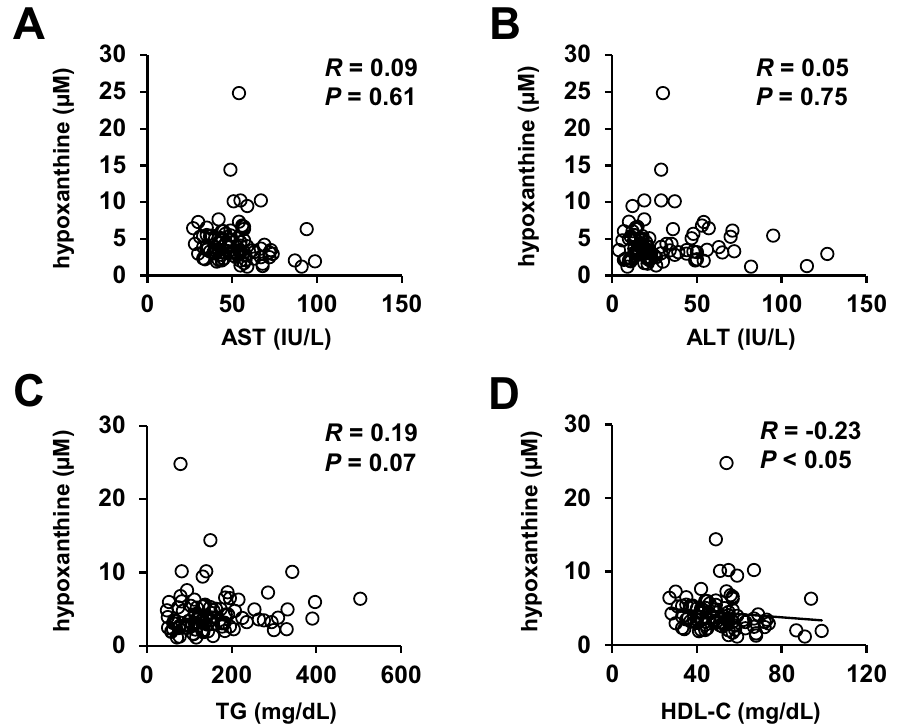
Figure 4. Correlations between the plasma hypoxanthine level and clinical parameters. Correlations between the plasma concentration of plasma hypoxanthine (µM) and serum levels of ( A ) AST (IU/L) and ( B ) ALT (IU/L), ( C ) TG (mg/dL), and ( D ) HDL-C (mg/dL).